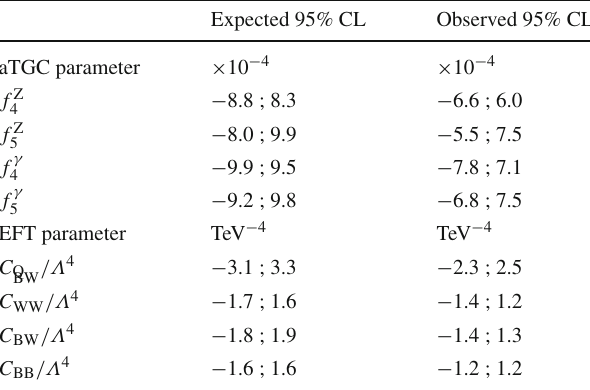
Table 5 Expected and observed one-dimensional 95% CL limits on aTGC parameters. The corresponding constrains on EFT parameters are estimated using the transformation from Ref.